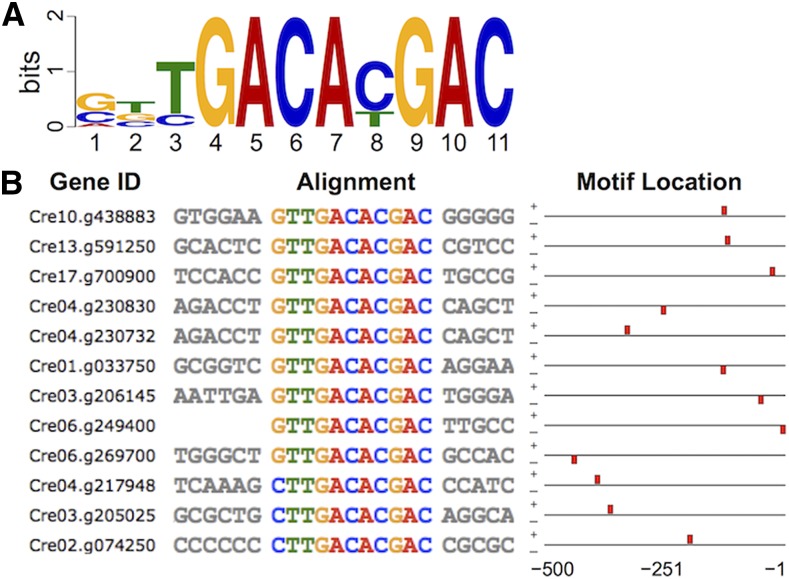
Identification of the ZYRE motif. (A) Logo representation of an enriched motif identified by MEME (Bailey and Elkan 1994) found upstream of start codons from a training set of the top 300 most highly expressed zygotic genes (Lopez et al. 2015). (B) Partial alignment of ZYRE motif-containing promoters in the training set. Block diagrams of the motif location and strand orientation (+ or −) relative to start codons with ZYREs represented by red boxes are shown.